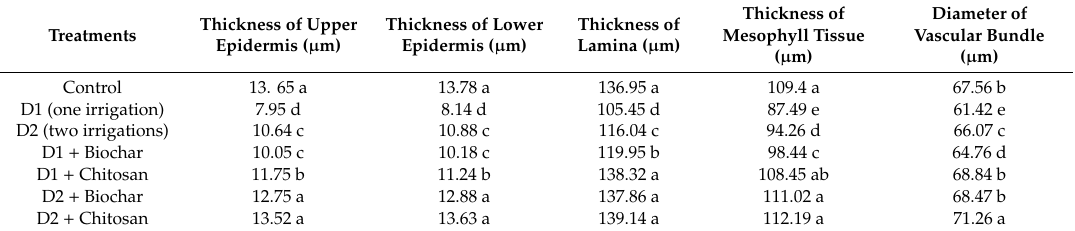
The numbers followed by di ff erent letters are significantly di ff